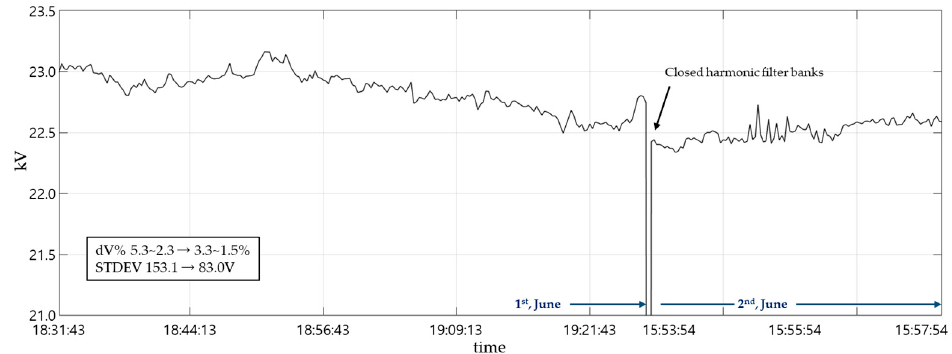
Figure 8. Measured V max for 22 kV plate mill Figure 8. Measured 𝑉 (cid:3040)(cid:3028)(cid:3051) for 22 kV plate mill system.